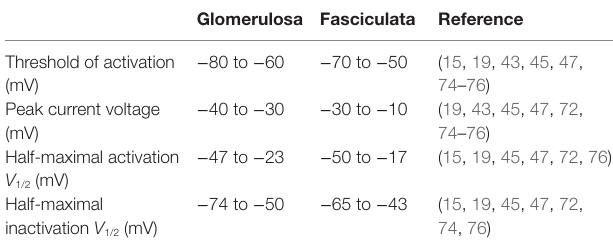
TABLe 3 | electrophysiological properties of T channels in adrenocortical